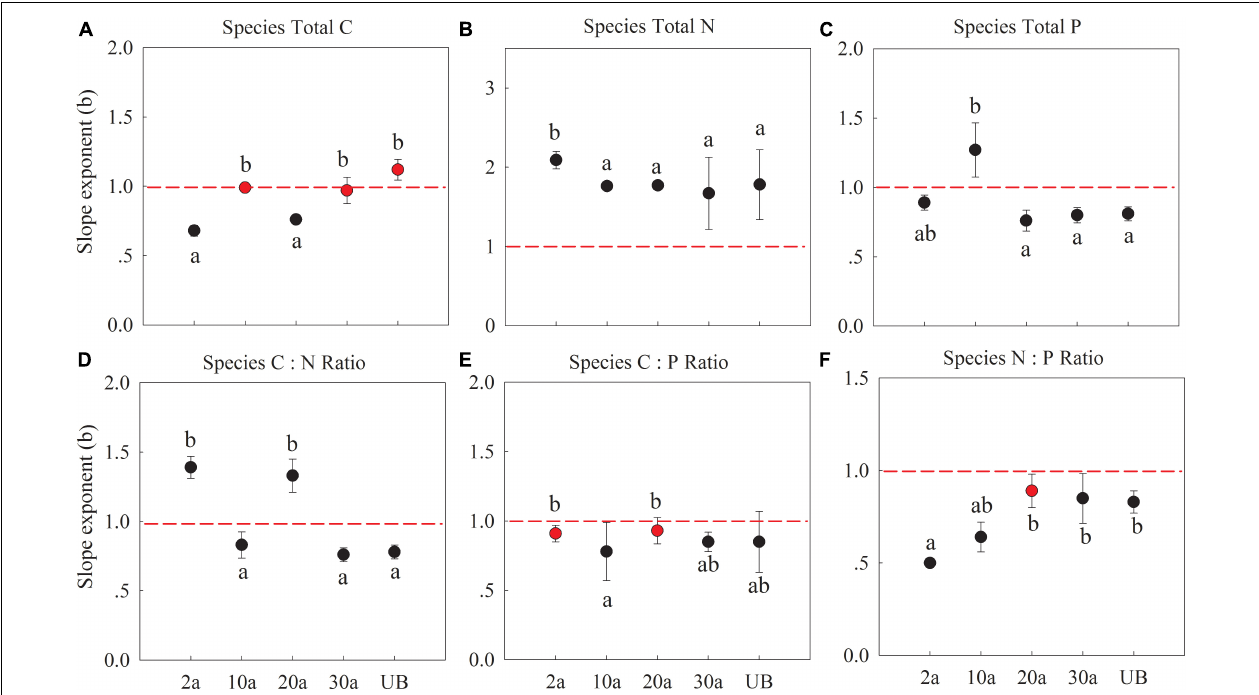
FIGURE 5 | Slope exponents (b) of C, N, and P between fine root (Y) and leaf (X) at the species level. 2a, 10a, 20a, and 30a are at year 2, year 10, year 20, and year 30 after recovery, respectively. UB, unburned. The sloping exponents of five recovery periods were shown with standard error. The slope exponents were estimated using reduced major axis (RMA) regressions. The summary of RMA, including intercept (a) and R 2 , is shown in Supplementary Table 2 . The number of the data involved in slope fitness in each recovery period was as follows: 2a: n = 39, 10a: n = 48, 20a: n = 36, 30a: n = 30, UB: n = 30. All regressions are significant at P < 0.05. Red dotted lines mean the slope is equal to 1. The red dots indicate that the exponents are not significantly different from 1 (isometric relationship) based on the likelihood tests. The different lowercase letters denote significant differences between the exponents within burned years based on the likelihood tests. (A–C) The stoichiometry concentration. (D–F) The stoichiometry